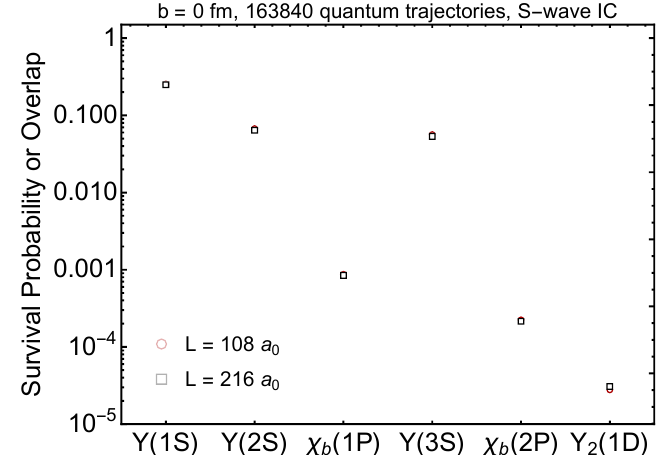
Figure 20 . Comparison of state survival probabilities for the 1 S , 2 S , and 3 S states and quantum mechanical overlaps for the 1 P and 2 P states obtained using two different box sizes corresponding to L = 108 a 0 (open red circles) and L = 216 a 0 (open black squares) with fixed lattice spacing. In both cases, we used S -wave Gaussian initial conditions with zero impact parameter b = 0 fm, T f = 250 MeV, ˆ κ ( T ) = ˆ κ C ( T ) , and ˆ γ = − 1 . 75